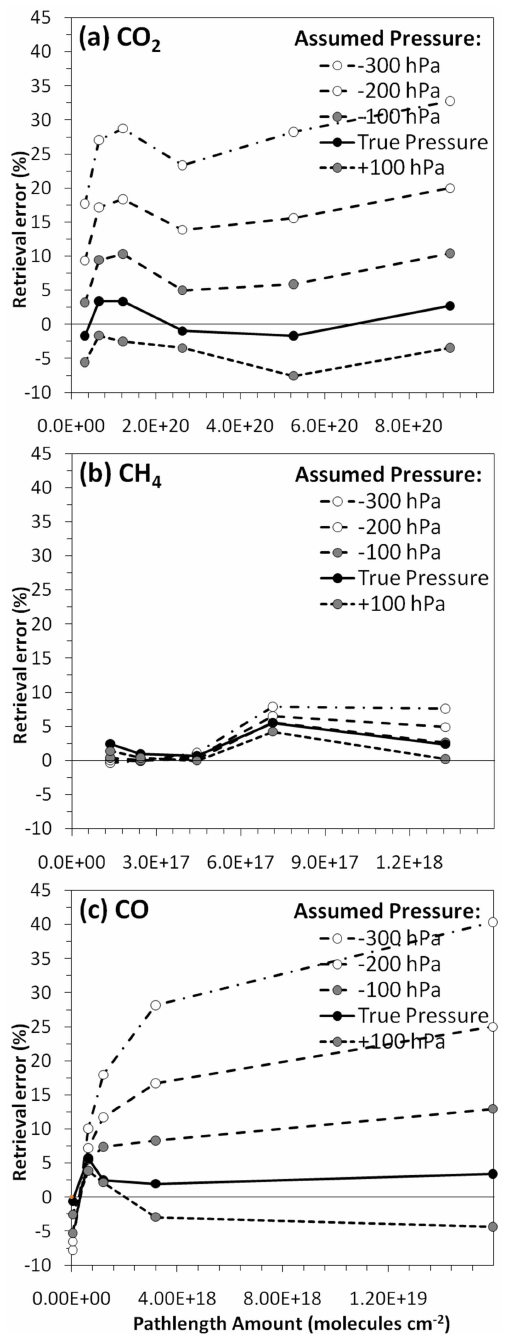
Fig. 10. Sensitivity of trace gas concentration retrieval error to the assumed gas pressure for (a) CO 2 , (b) CH 4 , and (c) CO. Retrievals were made using the MALT model with a NLLS fitting procedure. The same y-axis range is used in each case to aid comparison of error magnitude between